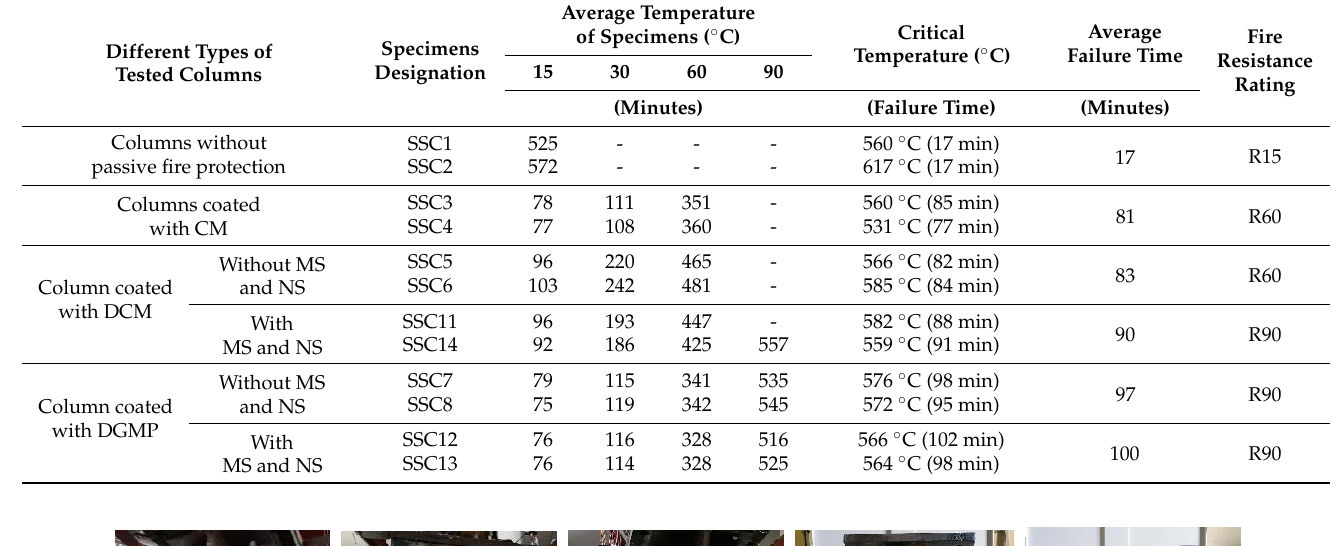
Table 8. Average temperature value obtained on the specimens of SSC. Figure 13. Evolution of temperature in the specimens of SSC as a function of time.